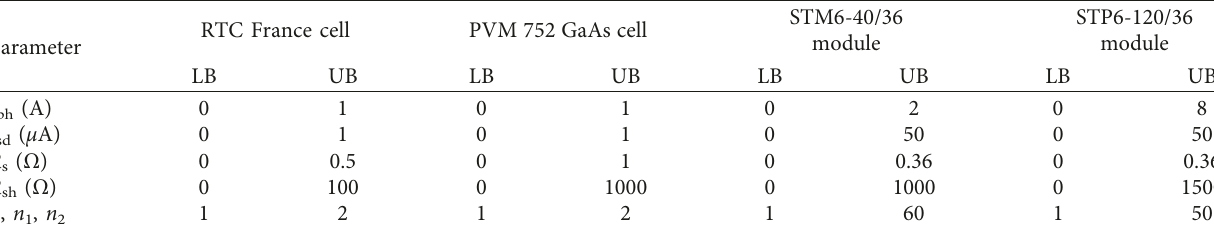
Table 1: Search ranges of parameters of PV models.